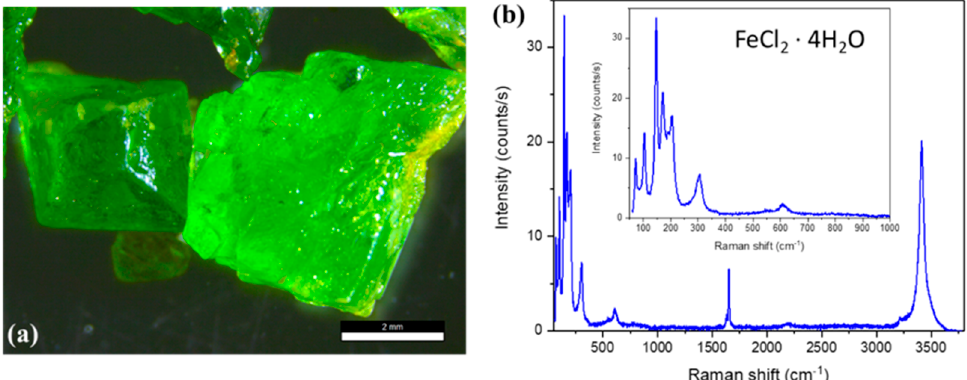
Figure 12. ( a ) Optical micrographs of the FeCl 2 ·4H 2 O crystals of larger size (scale bar of 2 mm). ( b ) Micro-Raman spectra recorded on the crystals of part ( a ).